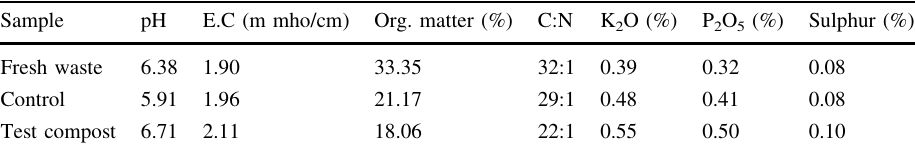
Table 8 Chemical analysis of the final compost